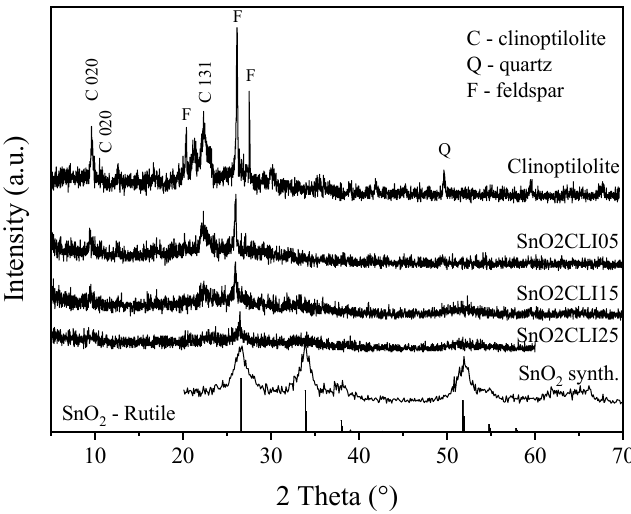
Figure 1. XRD patterns of SnO 2 from database (SnO 2 -Rutile), pure SnO 2 (SnO 2 synthesized), pure clinoptilolite (Clinoptilolite), and SnO 2 -containing clinoptilolite with different SnO 2 concentrations (SnO2CLI05, SnO2CLI15, SnO2CLI25).